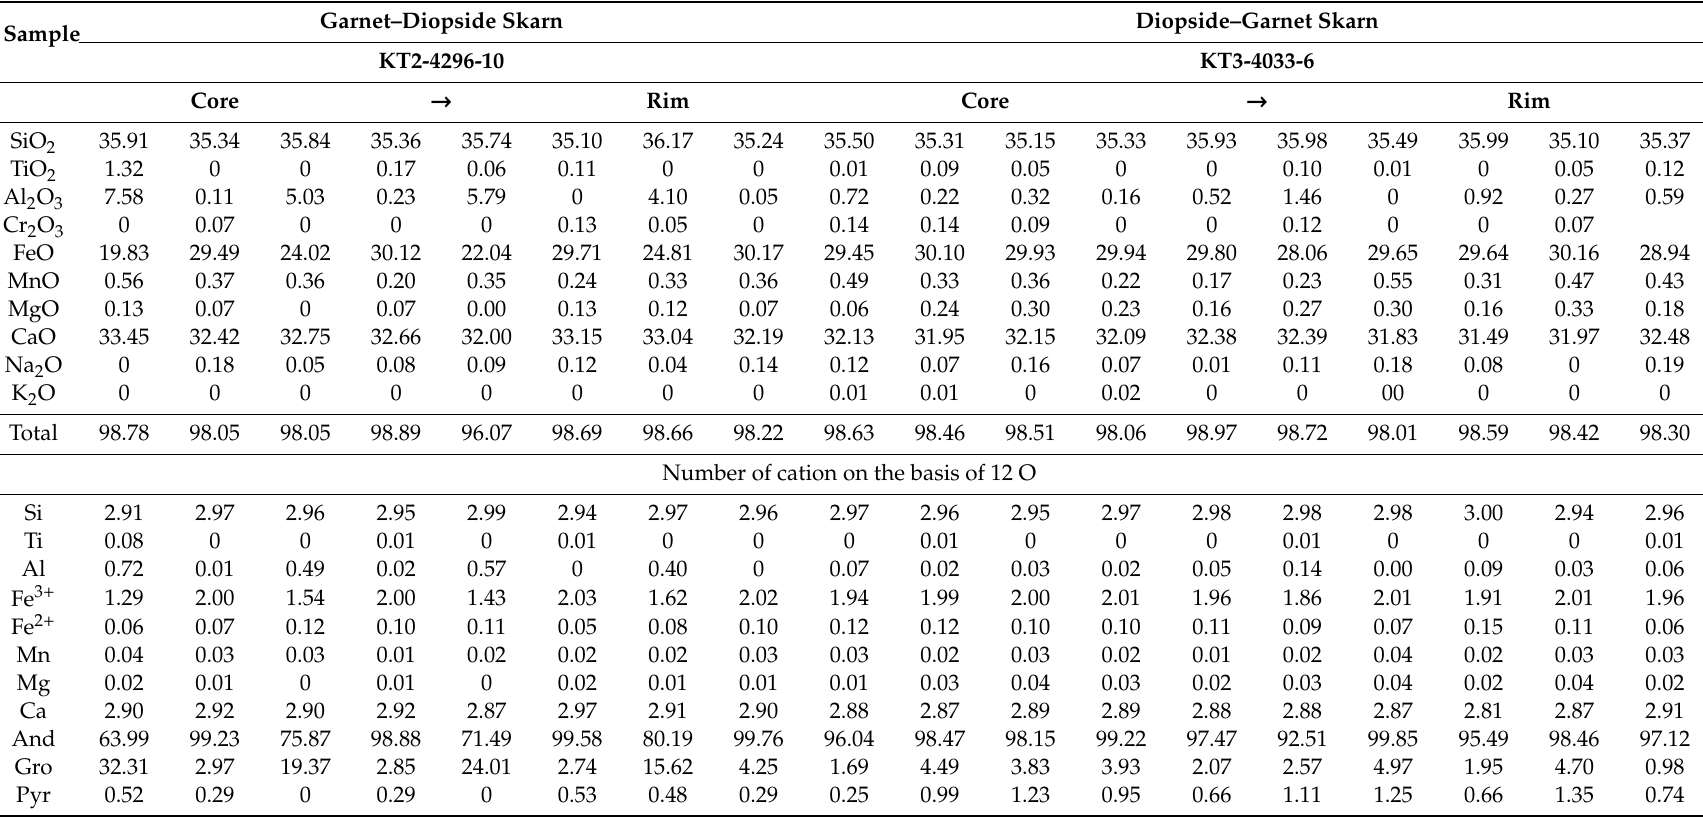
Table 3. Electron microprobe analyses of garnet from the Hongshan deposit (wt